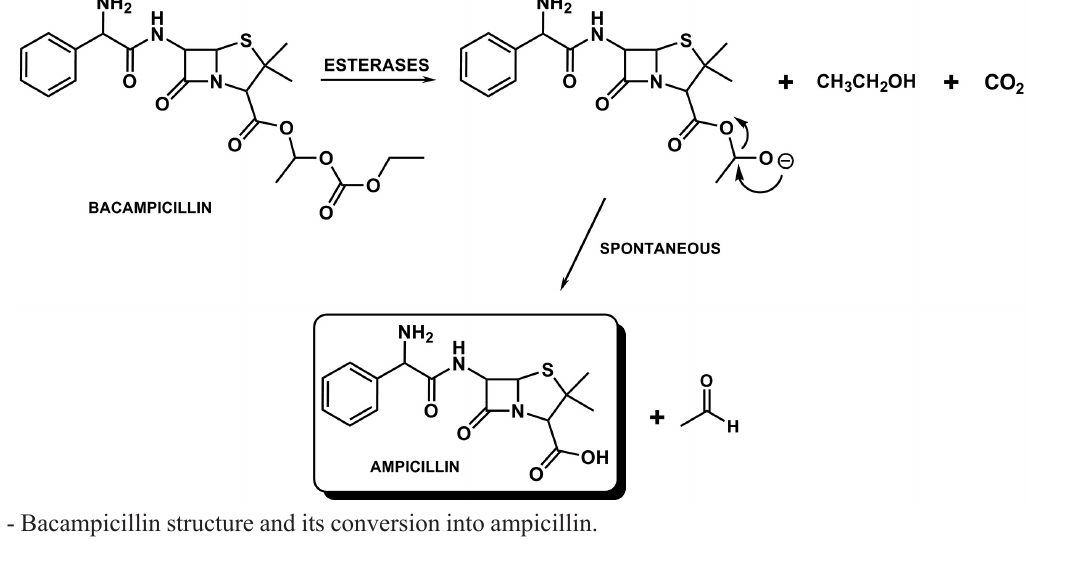
FIGURE 20 - Bacampicillin structure and its conversion into ampicillin.